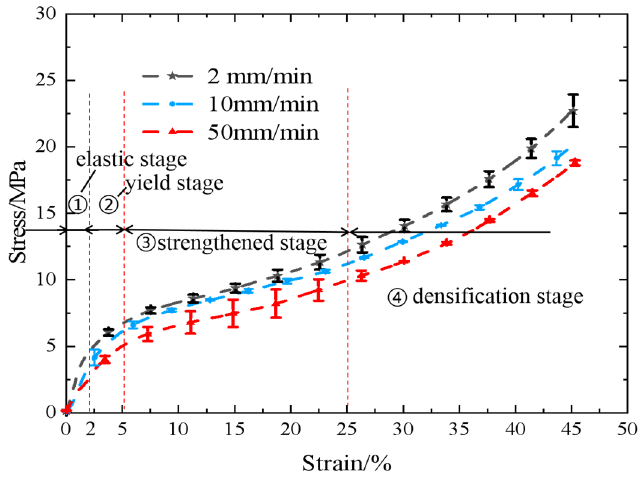
Figure 4. The engineering stress–strain curve error bar diagram of open-cell aluminum foam in quasi-static compression test.